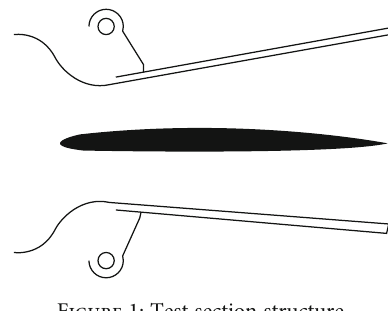
Figure 1: Test section structure. Table 1: Comparison of grid